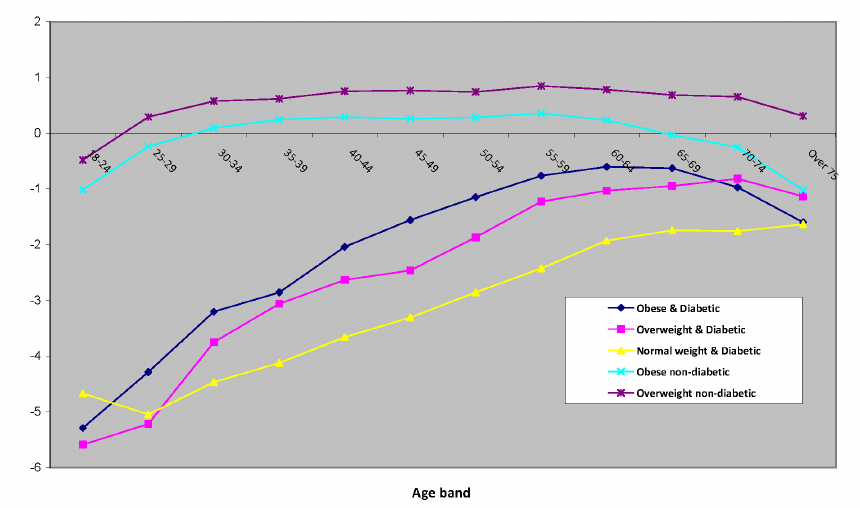
Figure 3 . Age profiles of the different diagnostic groups.